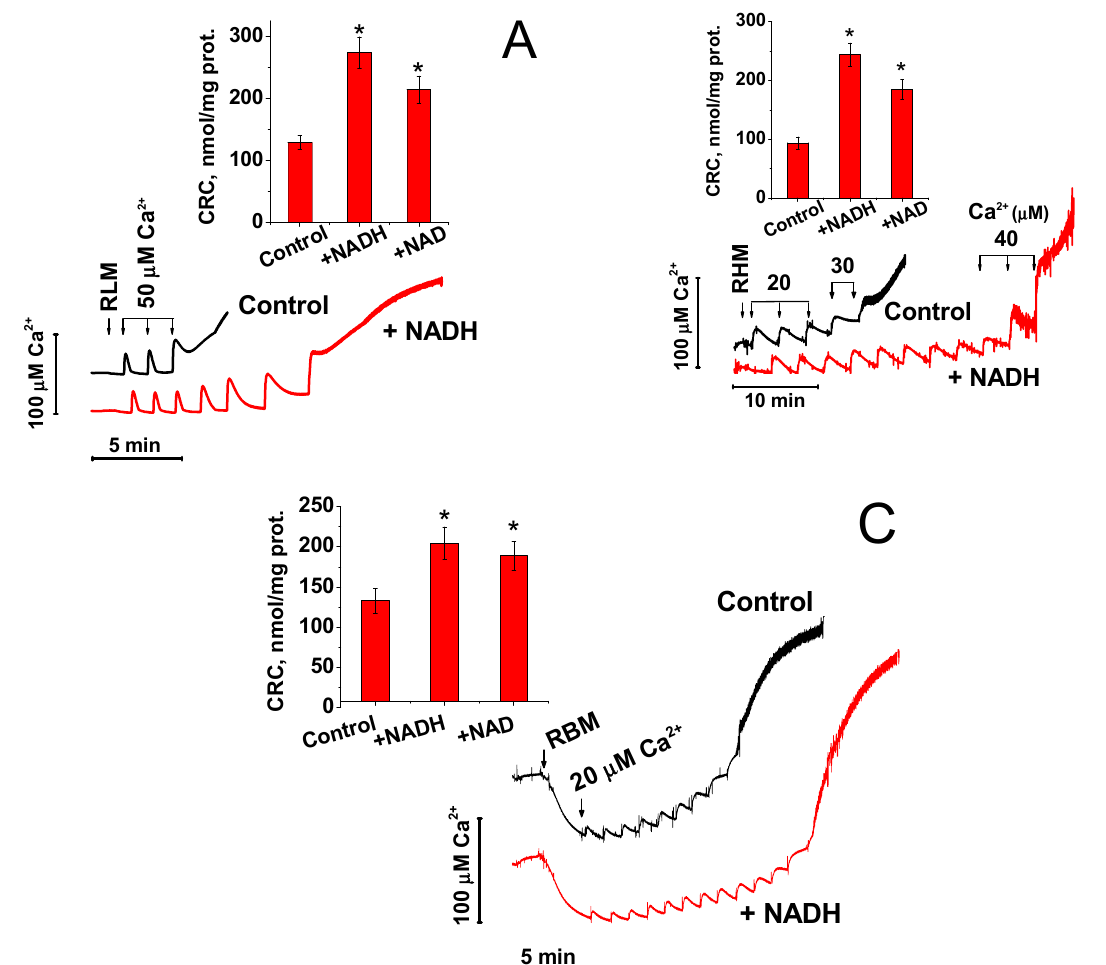
Figure 1. The effect of NADH and NAD + on the CRC of the liver ( A ), heart ( B ), and brain mitochondria ( C ). Prior to the measurements, mitochondria (1 mg prot./mL) were added to the standard KCl-BM supplemented with 1 mM NADH or 1 mM NAD + . Arrows show the addition of Ca 2+ by pulses of 20, 30, 40, and 50 µM. Representative curves of Ca 2+ accumulation are shown for RLM ( A ), RHM ( B ), and RBM ( C ). Bars in the inserts are the average values of retained Ca 2+ ± S.E.M ( n = 6) for three or more independent experiments. * p < 0.01.